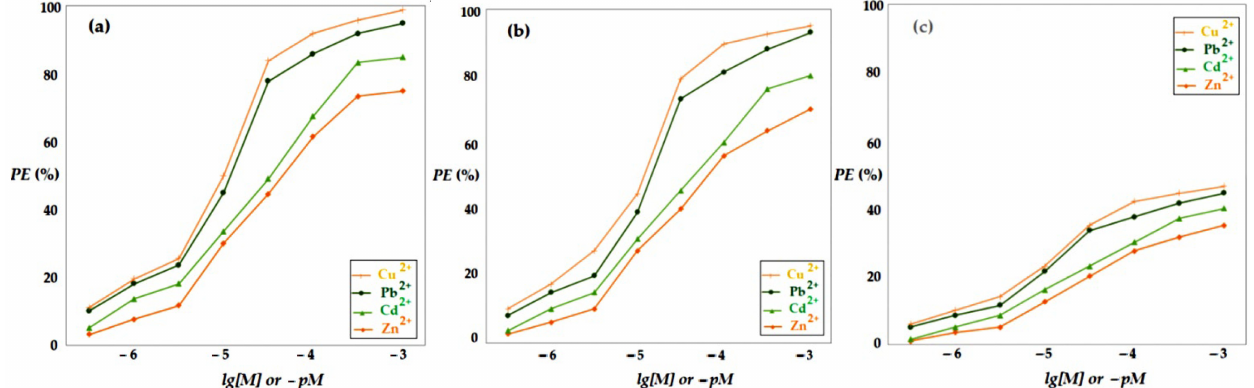
Figure 11. Hydrogen sulfide pertraction efficiency ( PE %) vs. pM for 20 ppm H 2 S in gas mixture: nitrogen ( a ); methane ( b ), and carbon dioxide ( c